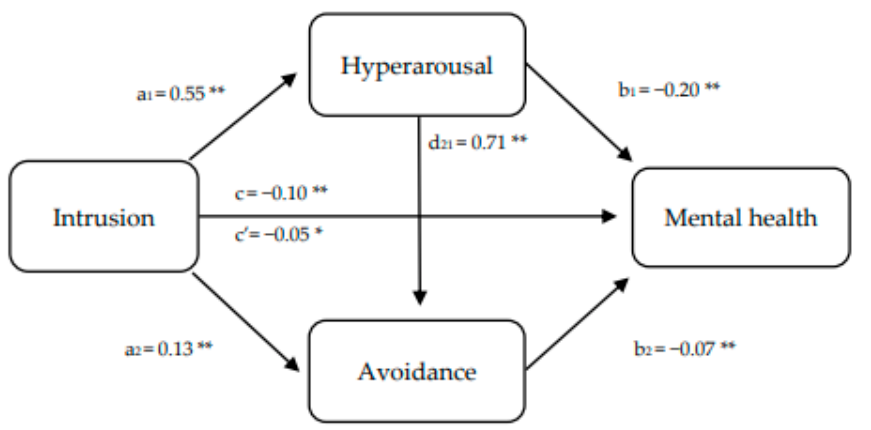
Figure 4. Sequential mediation model proposed to test the associations between intrusive thoughts, hyperarousal, avoidance, and mental health. * p < 0.05. ** p < 0.01.